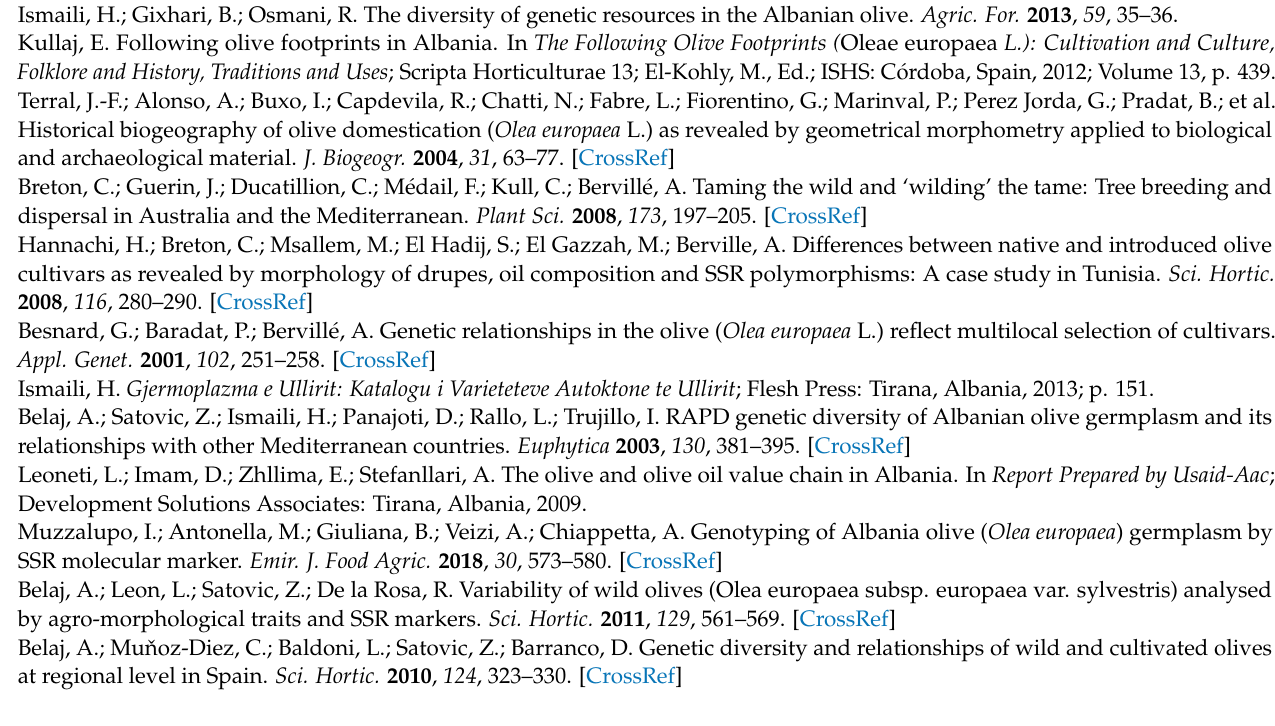
Table S4: The representation of Olive genotypes in each group identified by the Bayesian model- cluster method, Table S5: Accessions included in the core collection and their